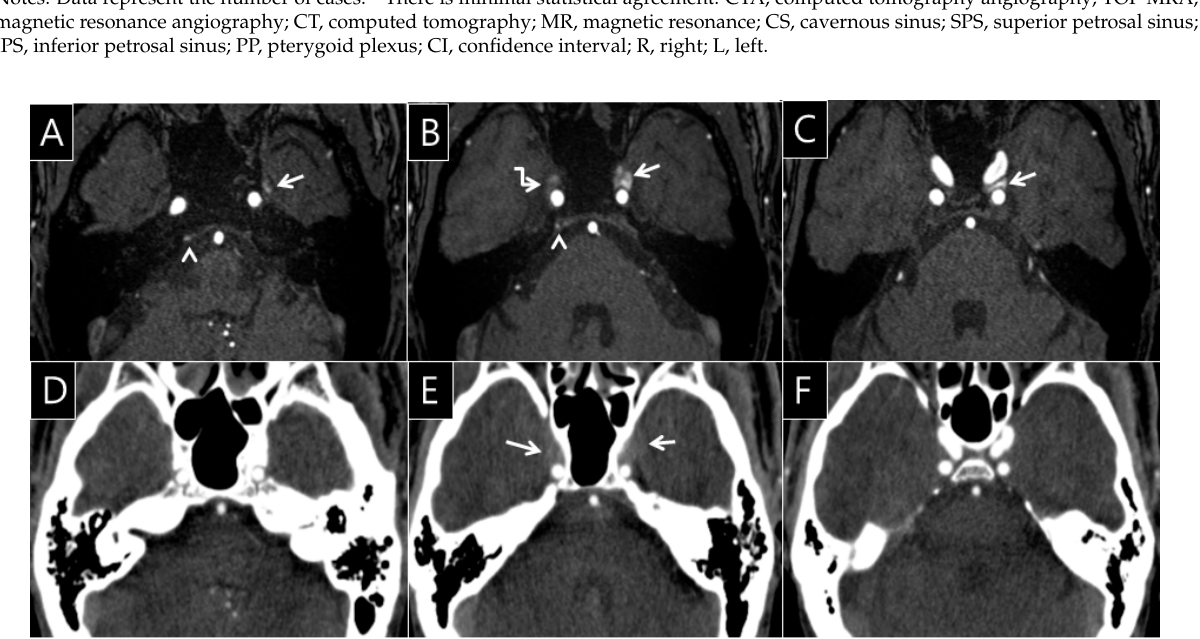
Figure 3. A 56-year-old man’s brain computed tomography angiography (CTA) and time of flight magnetic resonance angiography (TOF-MRA) images. On the TOF-MRA source images ( A – C ), the left pterygoid plexus (arrow, A ) shows FRSI on TOF-MRA ( A ). The FRSI is contiguous into the left CS, occupying more than one-third of the CS on TOF-MRA (arrows, B , C , grade IV). Mild FRSI was observed in the right inferior petrosal sinus (arrowhead, A , B , grade I) and right CS (broken arrow, B , grade III). However, the opacification of the venous sinus is less than or equal to the density of pons ( D , F , grade 0). The degree of opacification in the both CS is greater than the density of the pons in the same regions on brain CTA (arrows, E , grade I). Minimal agreement with the consensus score ( κ = 0.30, 95% confidence interval: 0.10–0.51) is shown; Note: κ , degree of intra-observer agreement between CTA and